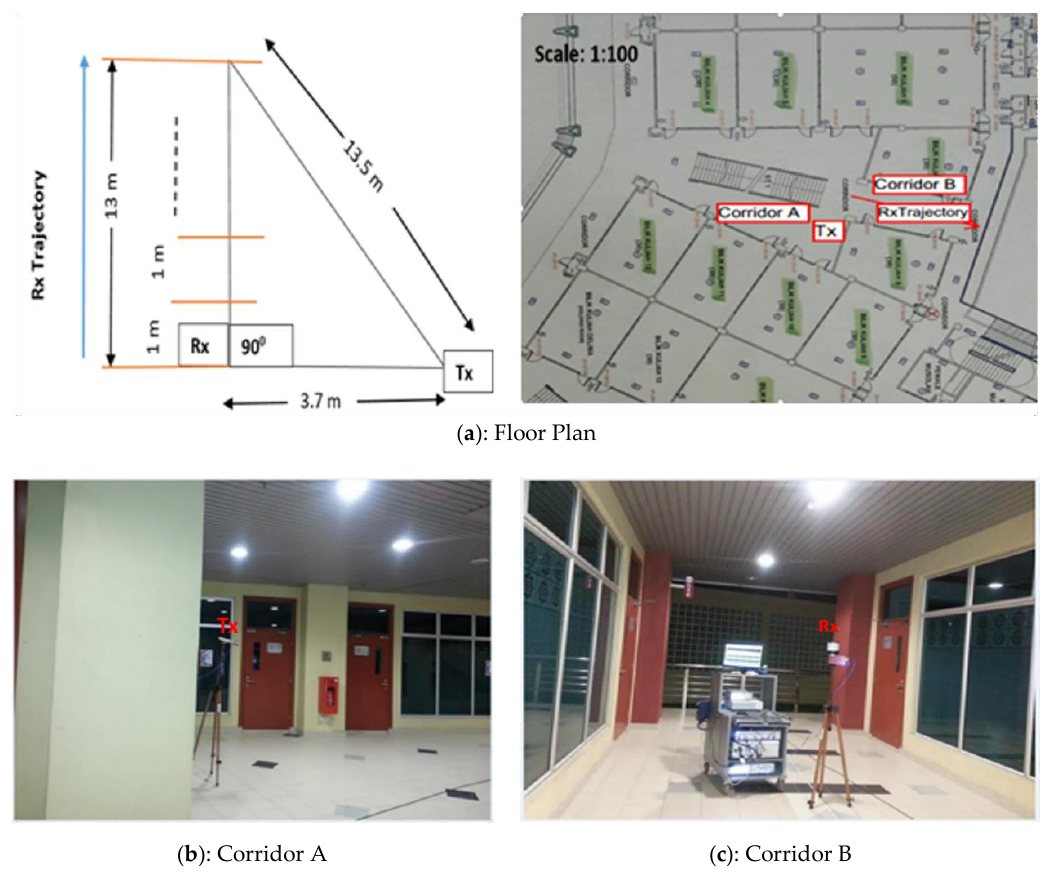
Figure 2. Measurement environment. ( a ) floor plan, ( b ) Tx location in Corridor A, and ( c ) Rx location in Corridor B.